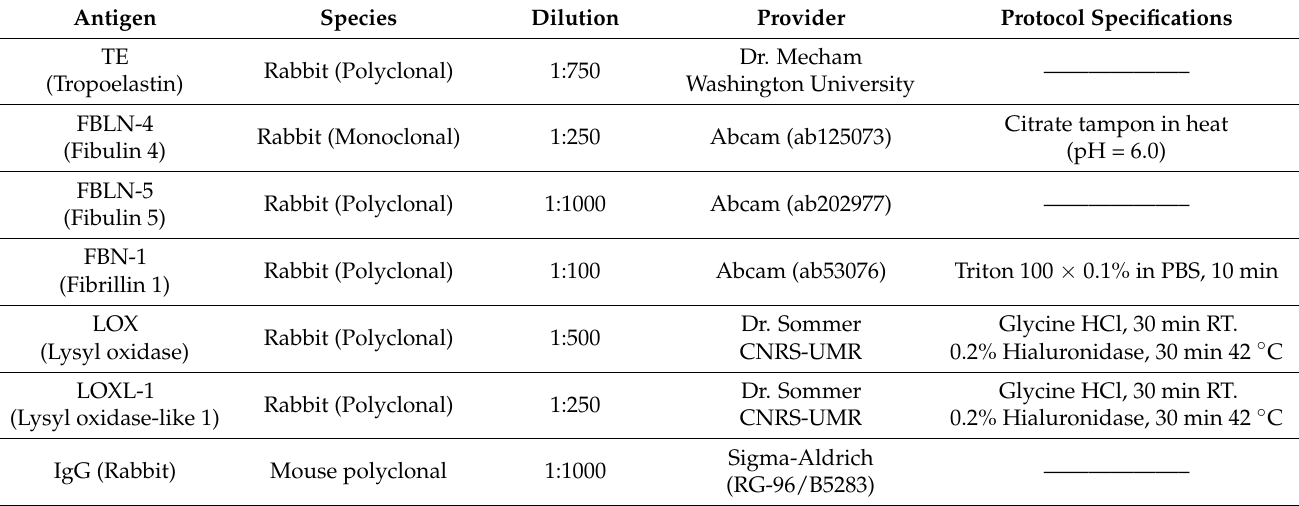
Table 2. Primary and secondary antibodies with dilution factors and protocol specifications in the immunohistological